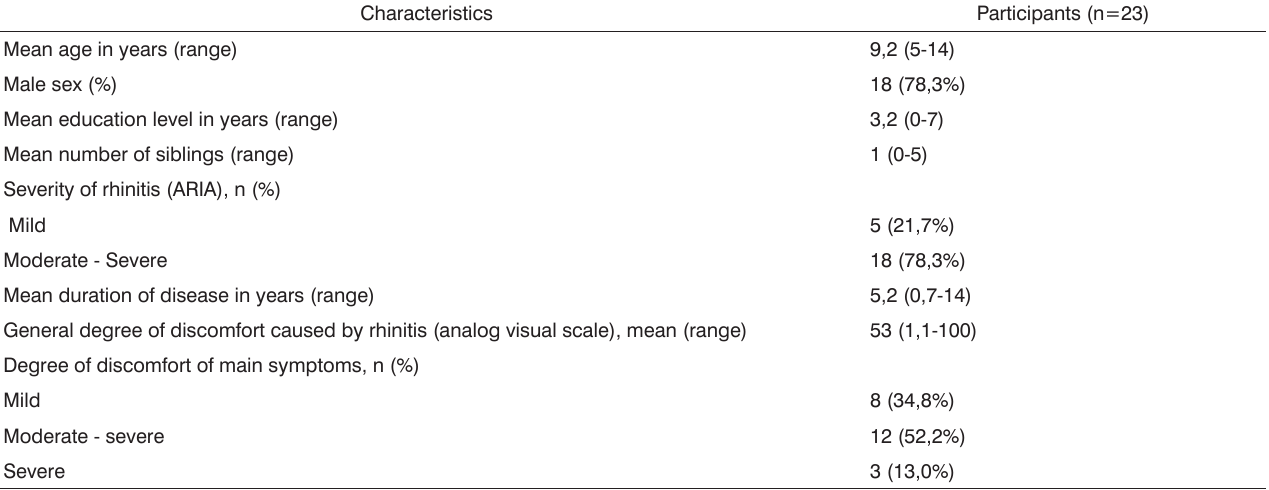
Characteristics